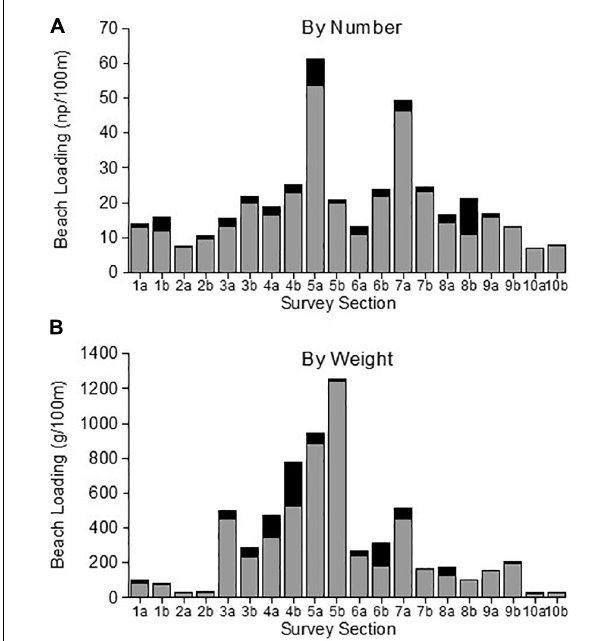
FIGURE 4 | Comparison of the spatial patterns of beach litter number density (np/100 m; A ) and beach litter weight density (g/100 m; B ). Histogram bars indicate total plastic (gray) and non-plastic (black) litter densities. Survey section numbers refer to the locations shown in Figure 1 . Values are the average loading from four quarterly surveys of each survey section–see Supplementary Material for survey